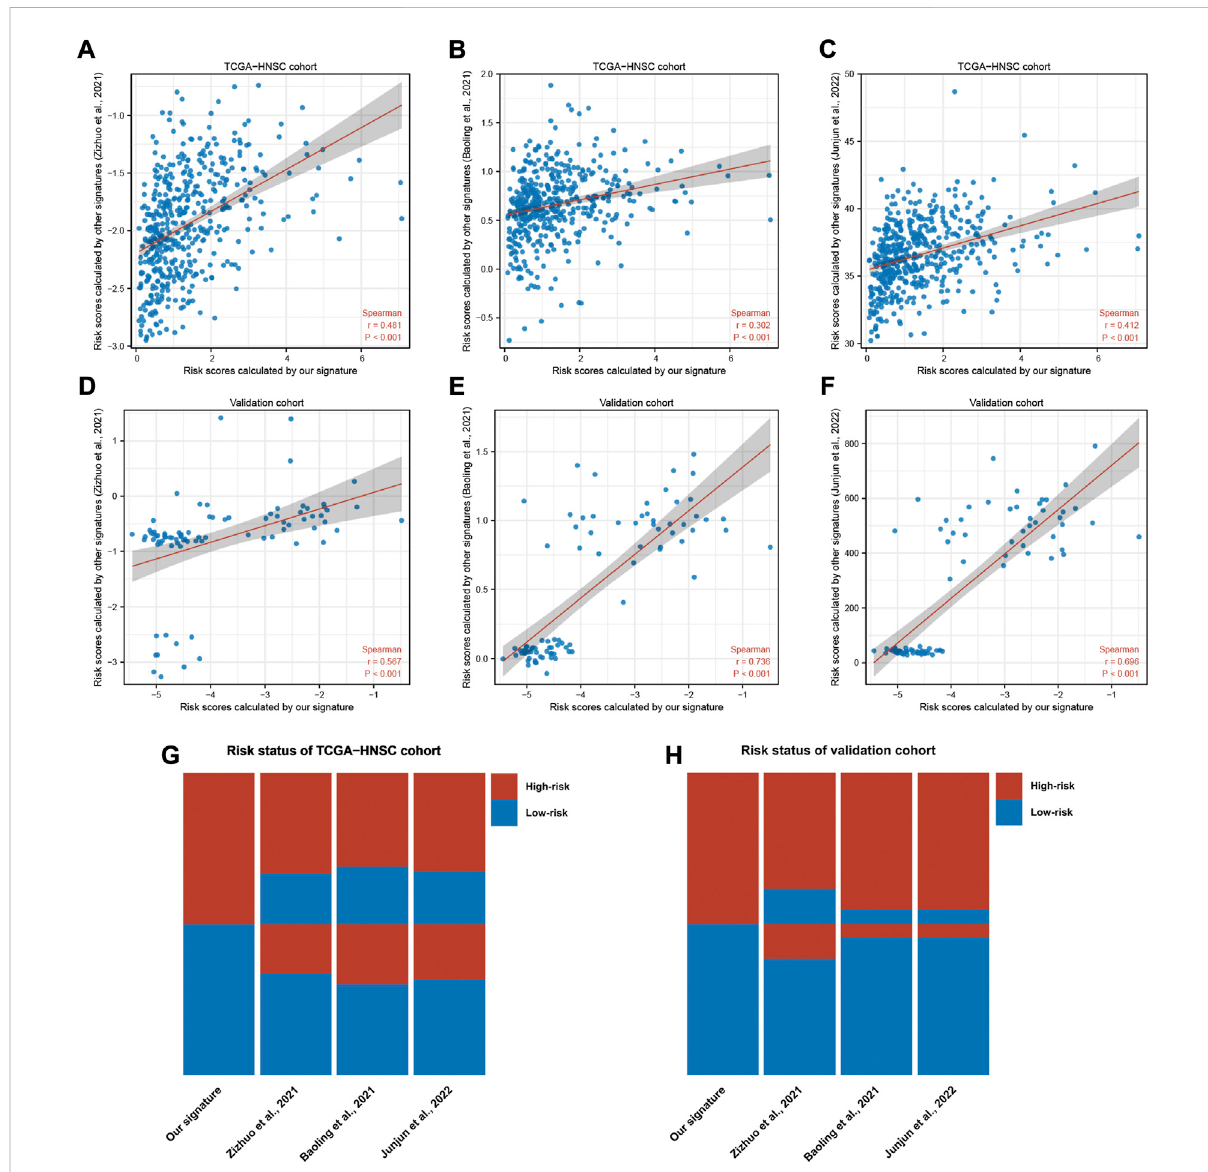
FIGURE 4 Validation of our signature in a independent HNSC cohort. (A – F) Scatter plots of correlations between the risk scores calculated by our signature and that calculated by reference signatures in TCGA-HNSC and independent cohort. Data were analyzed using Spearman ’ s